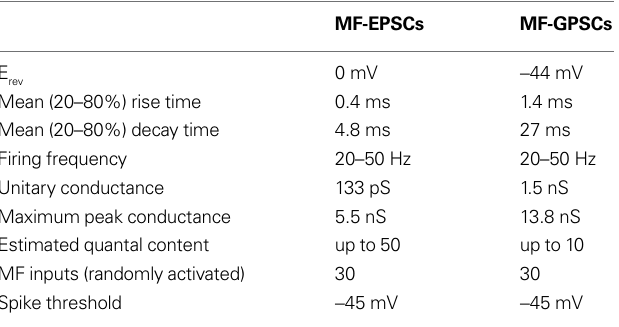
Table 1 | Comparison of the relative strength of CA3 pyramidal cells output in relation to their MF GABAergic or glutamatergic inputs.